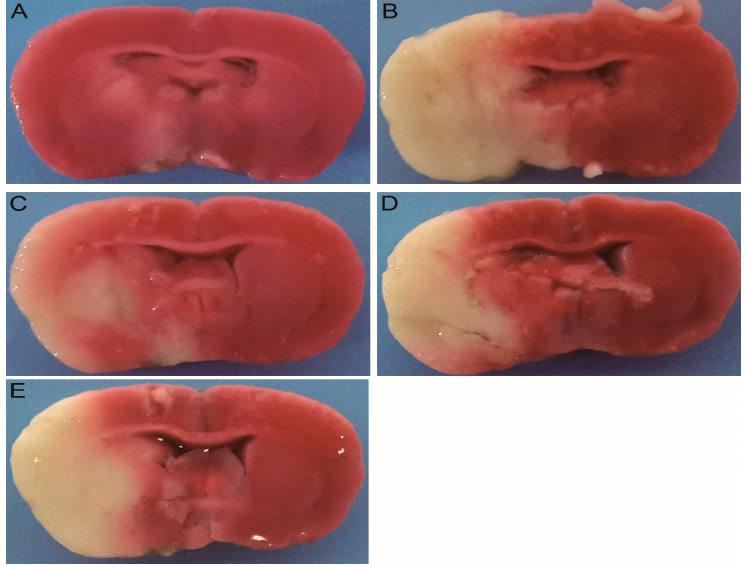
Figure 1. Triphenyltetrazolium chloride (TTC) staining results of brain tissue: The control group ( A ), model group ( B ), nimodipine group ( C ), high dosage of the ten-component combination derived from Naodesheng (NDS) (TCNDS) (H-TCNDS) group ( D ), and low dosage of TCNDS (L-TCNDS) group ( E ). H-TCNDS meaned high dosage of TCNDS (316.34 mg · kg − 1 · d − 1 ), and L-TCNDS meaned low dosage of TCNDS (158.17 mg · kg − 1 · d − 1 ).